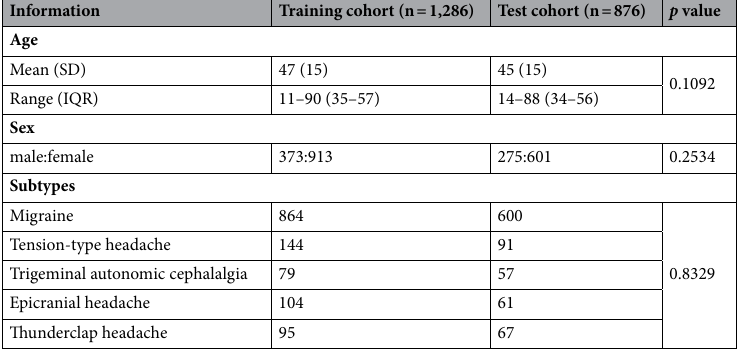
Table 1. Distribution of primary headache subtypes. Values are reported as mean with standard deviation in parenthesis. p values were obtained from the Kolmogorov–Smirnov test for continuous information and Chi- square test for categorical information. SD standard deviation, IQR inter-quartile